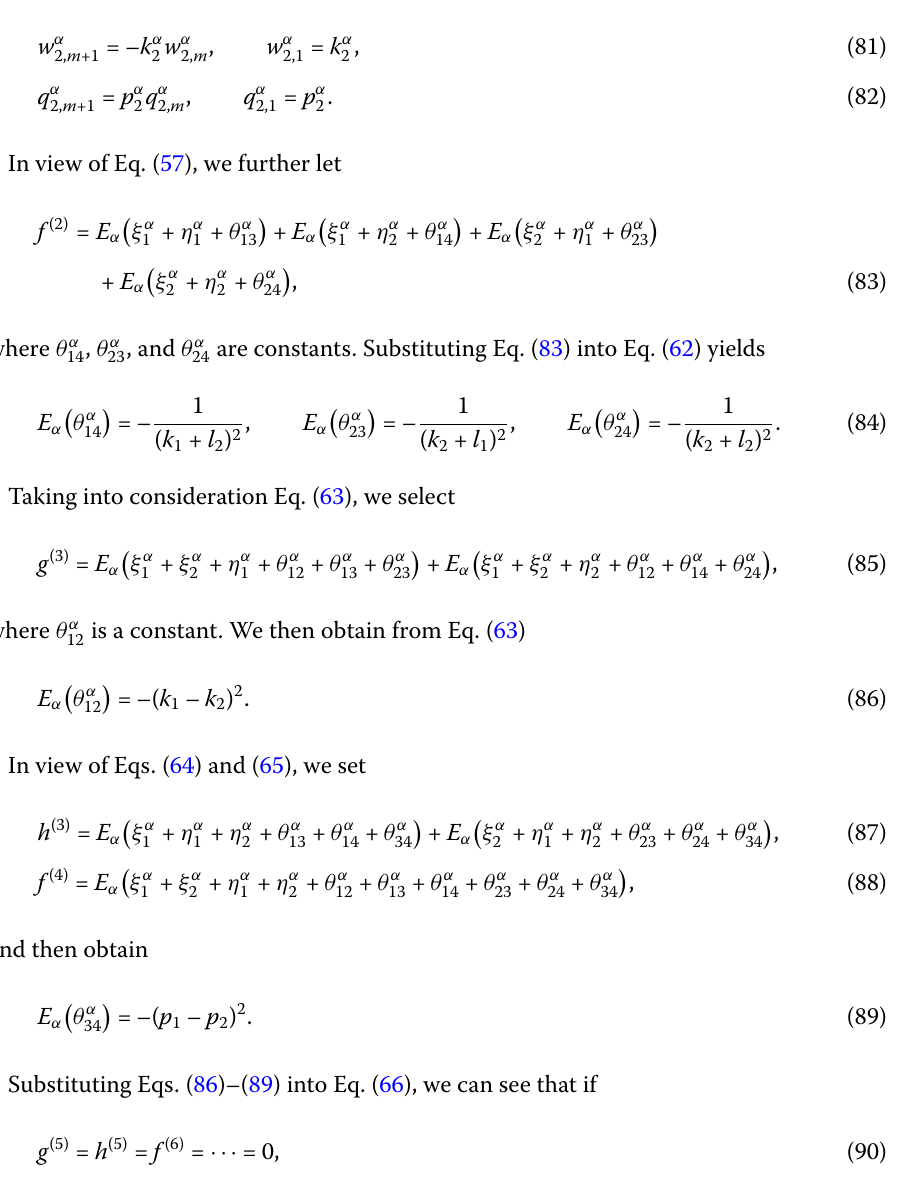
and substitute Eqs. (79) and (80) into Eqs. (60) and (61). Then the resulting equations